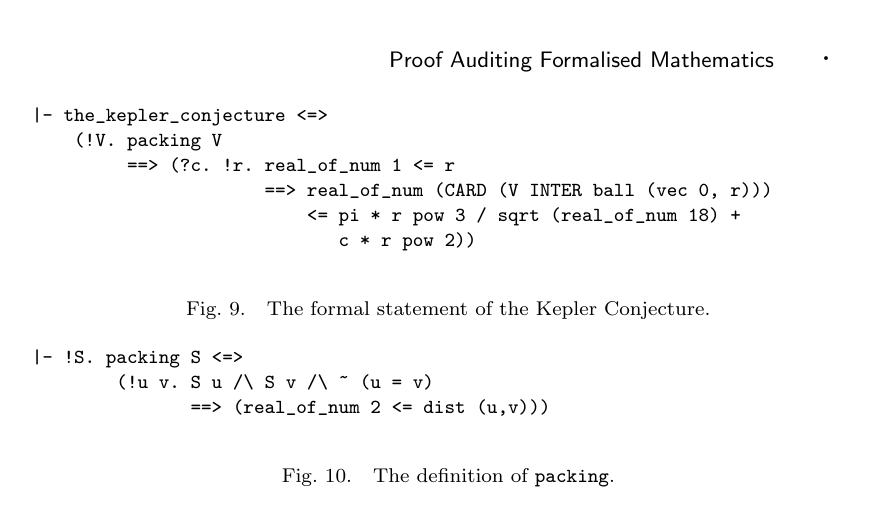
Fig. 10. The definition of packing